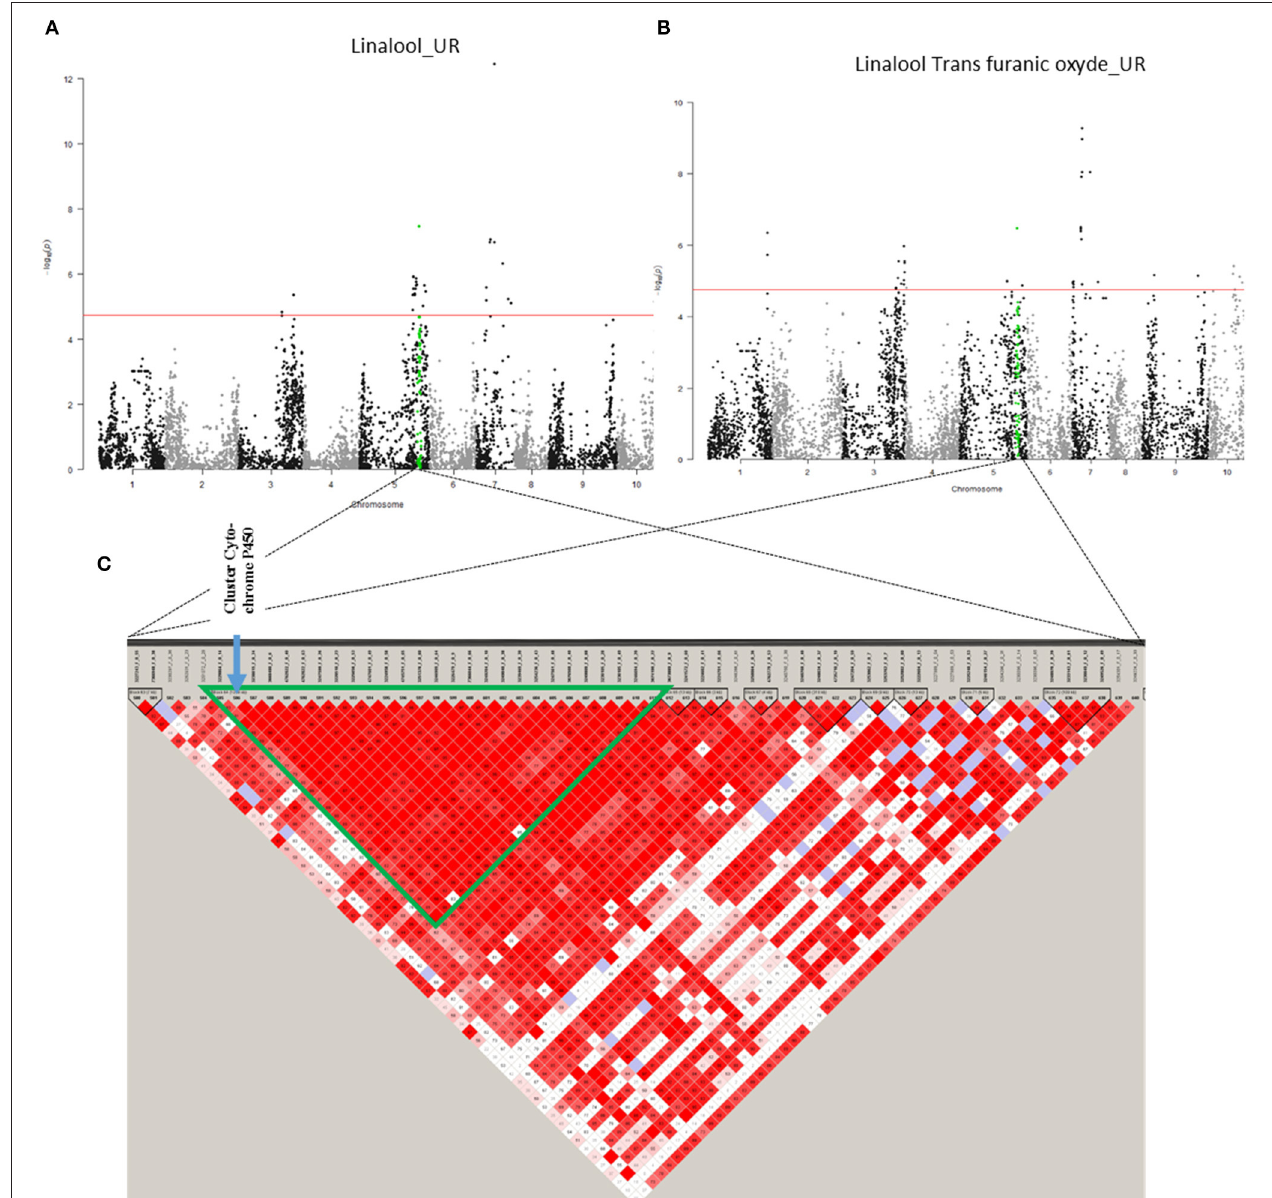
FIGURE 7 | Co-localisation between linalool (UR) and trans furanic oxide (UR) with candidate genes. (A) Manhattan plot representing association results for the Linalool (UR) trait, revealed by GLM-MAF5 method. (B) Manhattan plot representing association results for linalool trans furanic oxide (UR) trait, revealed by GLM-MAF5 method. (C) Heat map of a part of chromosome 5. The common region of association is represented by a green triangle.